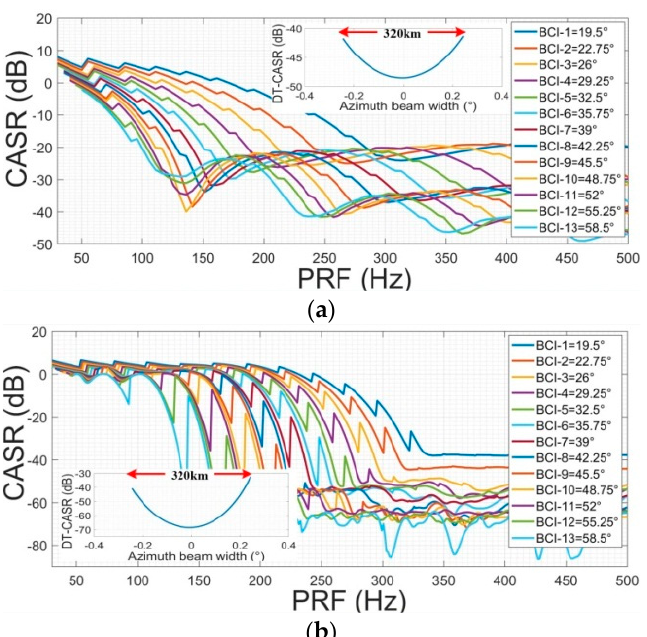
Figure 16. CASR and DT-CASR of Geo-SAR at a latitude argument of 23.4°. ( a ) Broadside, latitude argument of 23.4°. ( b ) 60° squint, latitude argument of 23.4°.